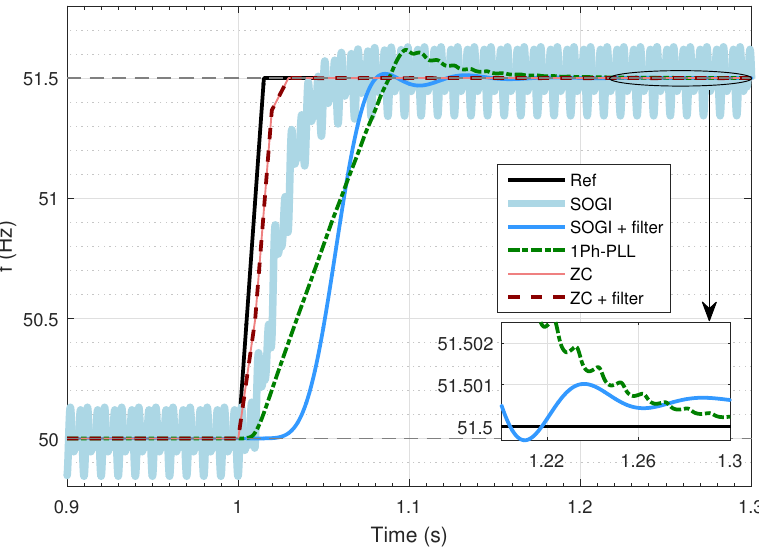
Figure 1. Frequency estimation performance analysis for various PLL configurations. The zero crossing (ZC) detection is for reference while SOGI (SOGI-FLL) with-out and with low-pass filter and PLL implementation (1Ph-PLL) from Matlab are compared. The f c has been set to 20